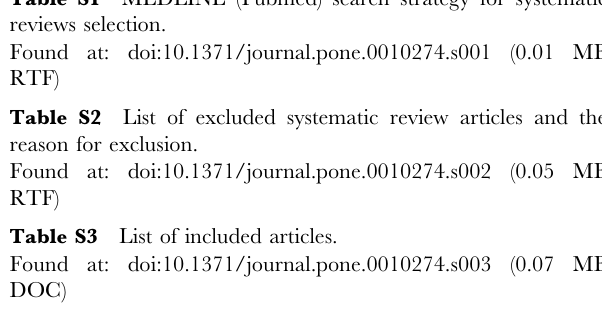
Table S1 MEDLINE (Pubmed) search strategy for systematic reviews selection.